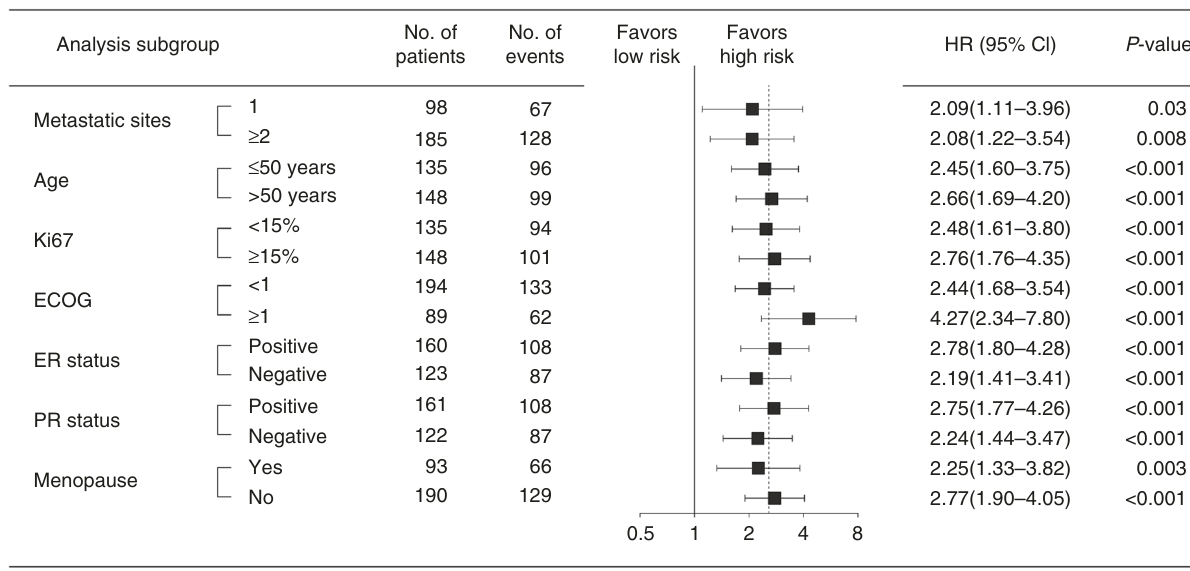
Fig. 3 Forest plot for performance on PFS of predictive risk score strati fi ed by clinicopathological features based on the Cox models. P -values were calculated using the two-sided log-rank test. HR and 95% CIs were given and visually represented by the squares and error bars. ECOG Eastern Cooperative Oncology Cohort, ER estrogen receptor, PR progesterone receptor, HR hazard ratio, 95% CI 95% con fi dence